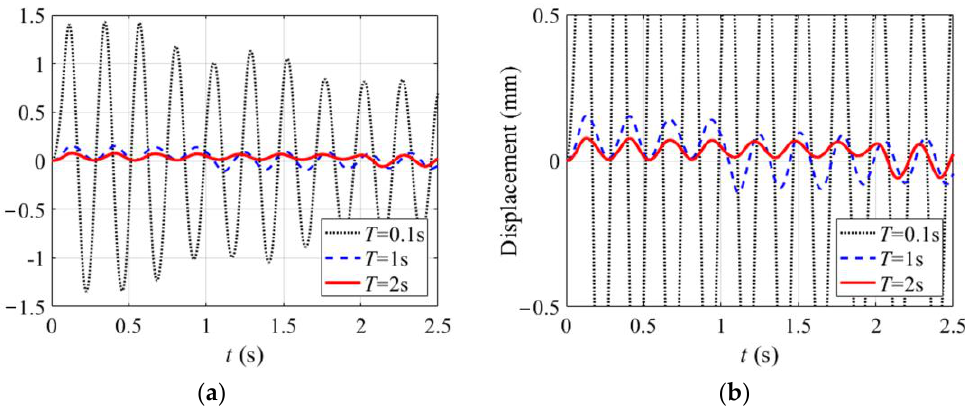
Figure 9. Time histories of point A of M3, ω 0 = π /5 (rad/s). ( a ) The overall responses. ( b ) The details of the responses.